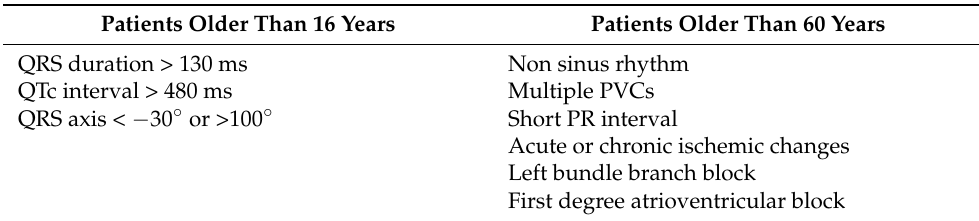
Table 2. High-risk ECG features predictive of 30-day adverse outcomes [38,43].